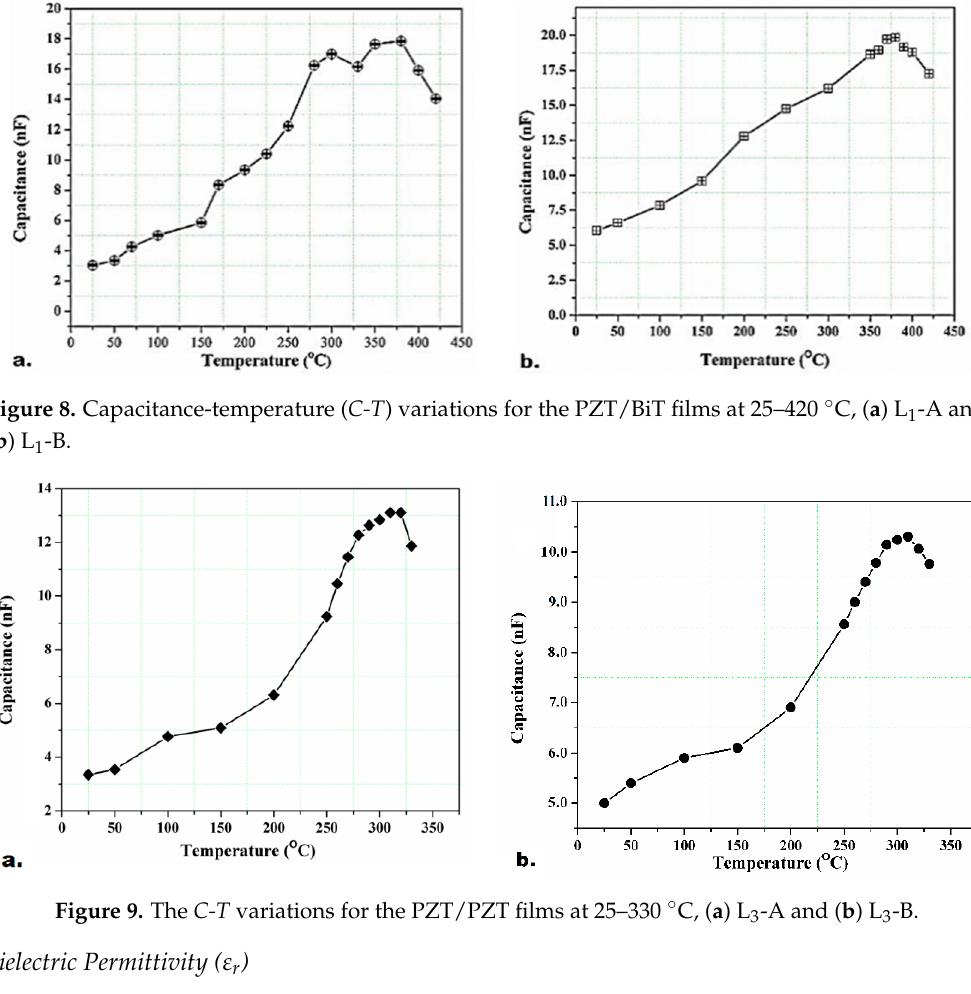
Figure 10. Variation of dielectric permittivity in piezoelectric composite films of [ k 1 C + k 2 S] structure. The same hold true over the blades of type S such that the S 6 -PZT/BiT films show higher permittivity than S 5 -PZT/PZT films. Except for porosity, another effective parameter on the characteristics of the thick composite films is the volumetric ratio of PZT powder to the sol-gel solution.